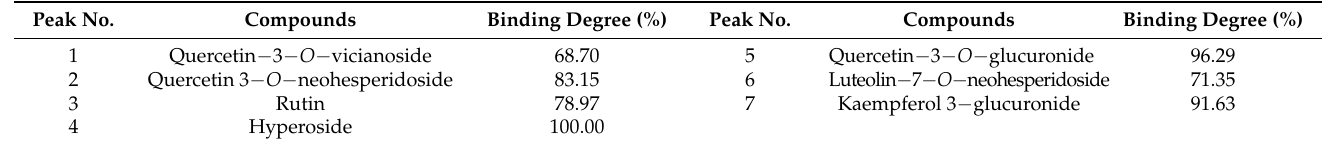
Figure 4. The chromatograms of PVR interacted with alpha-glucosidase. ( a ) Control group (with inactive alpha-glucosidase); ( b ) experimental group (with active alpha-glucosidase). Quercetin − 3 − O − vicianoside ( 1 ), quercetin 3 − O − neohesperidoside ( 2 ), rutin ( 3 ), hyperoside ( 4 ), quercetin − 3 − O − glucuronide ( 5 ), luteolin − 7 − O − neohesperidoside ( 6 ), kaempferol 3 − glucuronide ( 7 ). Table 2. The binding degree of compounds with